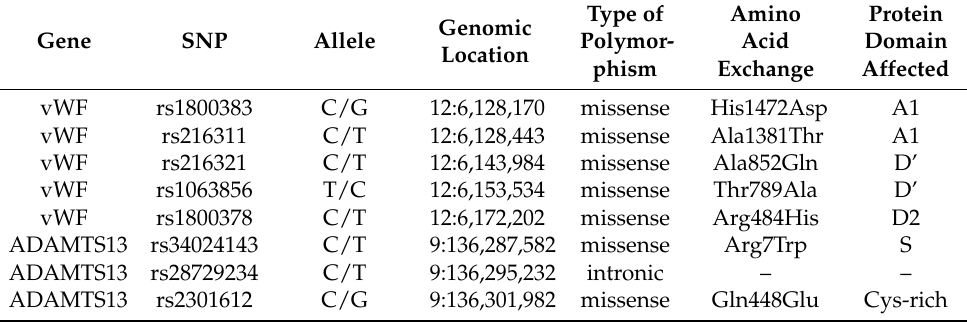
Table 3. Data of SNPs involved in our study. Genomic locations of SNPs are shown according to the Genome Reference Consortium Human Build 37 patch release 13 (GRCh37.p13). Alleles and the corresponding amino acids in the encoded protein variants are shown in the ’major/minor’ order, as obtained from the gnomAD database. rs: Reference SNP cluster ID.